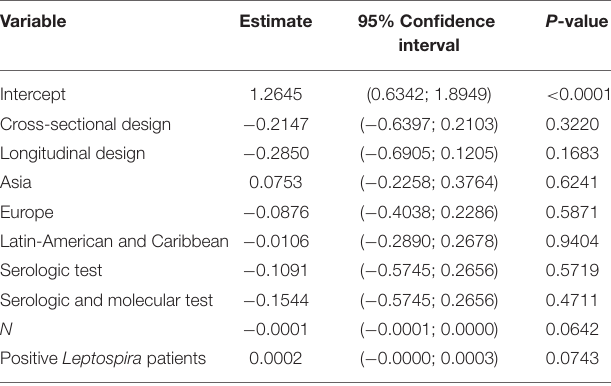
TABLE 4 | Summary of metaregression analysis outputs for the variables that influenced the proportion of fever and two more symptoms at suspicious patients of